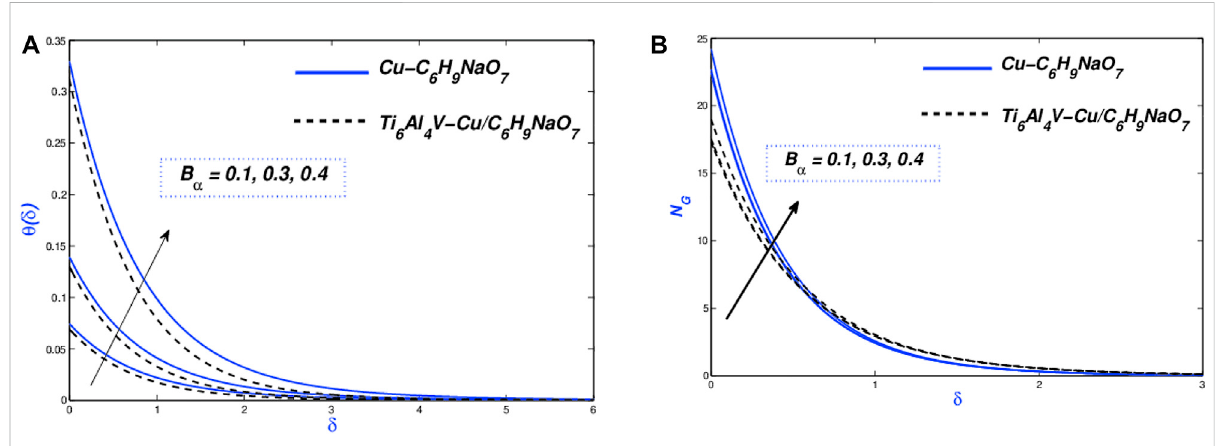
FIGURE 8 (A) θ ( Γ ) and (B) N G with diverse B α values.